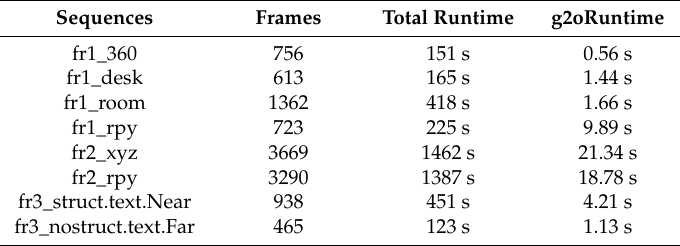
Table 2. Running time of the TUM RGB-D